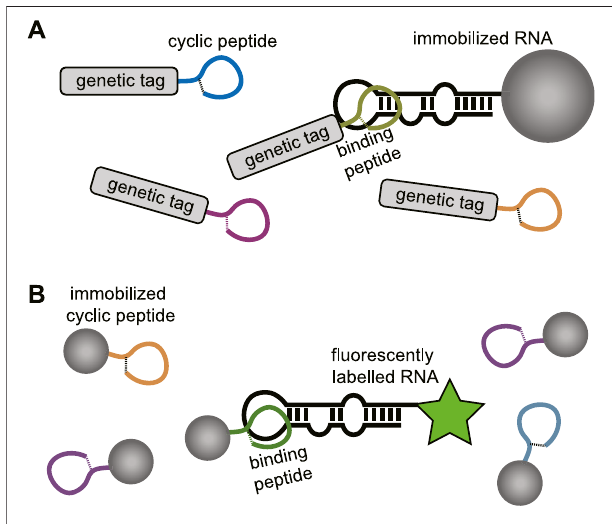
FIGURE 10 | (A) Screening of genetically encoded peptides (i.e., mRNA or phage display). using an immobilized RNA target. (B) Screening of bead- bound synthetic peptides using a fl uorescently labelled